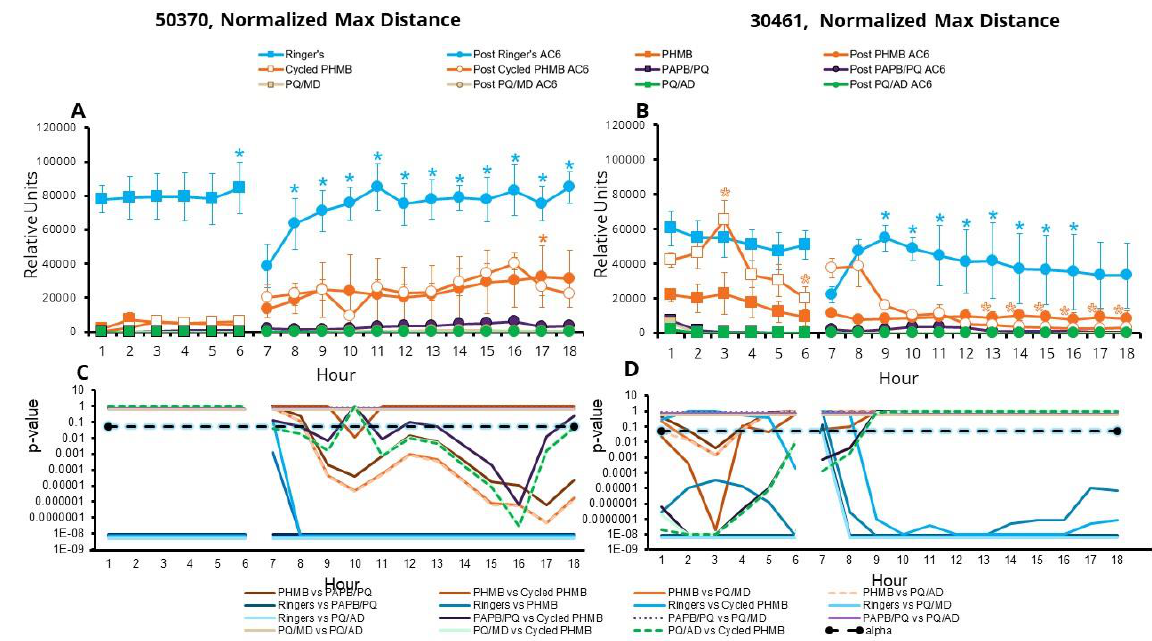
Figure 5. Surviving Acanthamoebae recover max distance traveled after disinfection. Amoebae were disinfected or put in one-quarter Ringer’s solution for the first 6 h, followed by AC6 media for the following 12 h (total 18 h). Normalized max distance is presented as mean ± SE. ( A ) Acanthamoeba castellanii (ATCC 50370), and ( B ) Acanthamoeba polyphaga (ATCC 30461). Relative units: average maximum distance moved by each amoeba in the field of view, multiplied by the number of moving amoebae, resulting in the total number of microns moved by all amoebae. * p < 0.05 vs. each condition’s own baseline (either hour 1 or hour 7 for CLC or AC6 conditions, respectively). Statistical comparisons between conditions are represented in ( C ) p -values for ( A ), and ( D ) p -values for ( B ). Alpha was set at 0.05. n = 3/group.